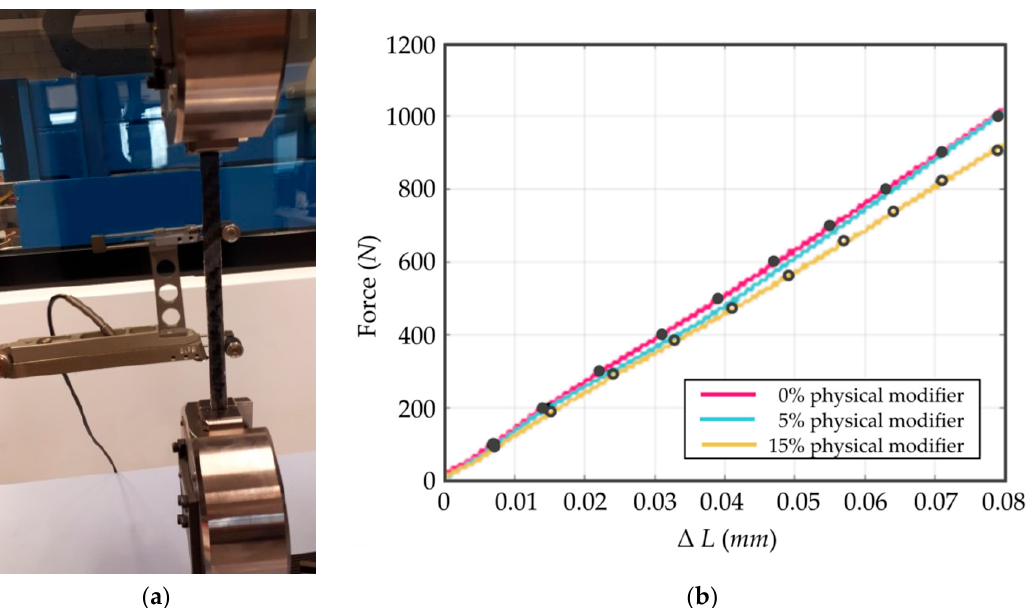
Figure 4. ( a ) Evaluating the mechanical properties of the composite material using a Shimadzu universal testing machine and ( b ) the characteristics of the material for the modulus of elasticity, which resulted from the tensile testing for three cases of the share modifier included in the composite.